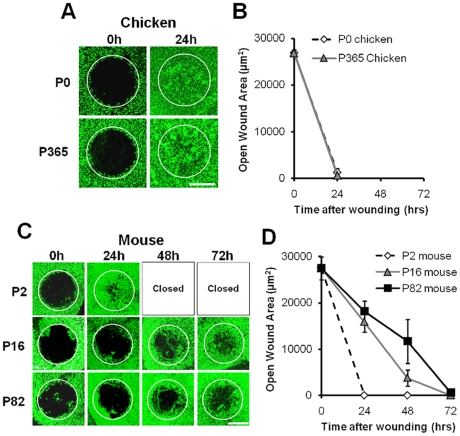
Utricles from chickens and young mice close wounds faster than utricles from older mice.(A) Z-projected confocal image stacks (20×/0.75NA objective) of wounded utricles from P0 and P365 chickens. Utricles were fixed after wounding at the designated time points and labeled with phalloidin (green) to view F-actin in the apical junctions of cells. Wounds are almost closed by 24 hours (initial size of wound shown with white circles). (B) Quantification of open wound areas versus time after wounding in chicken utricles (n = 6 for each age group). (C) Wounds in utricles from P2 mice are completely closed within 24 hours. Wounds in utricles from P16 and P82 mice, however, take 72 hours to close. Scale bars in A and C, 100 µm. (D) Graphs of open wound areas versus time after wounding demonstrate that wound closure times and rates decline with age in mice.